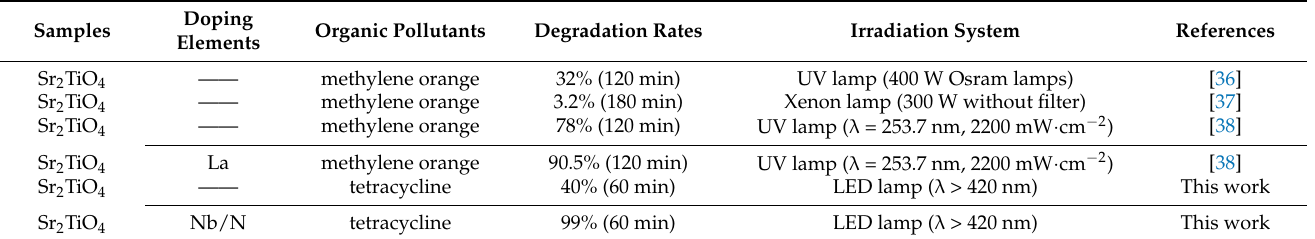
Figure 9. ( a ) Adsorption of different photocatalysts towards TC; ( b ) Self-degradation rate and degradation rate with different photocatalysts of tetracycline under visible light; ( c ) pseudo-first order kinetics curves of the photocatalytic degradation of TC; ( d ) degradation rate of TC after repeated cycles by Sr 2 TiO 4 :N,Nb(2%). Table 3. Photocatalytic properties of Sr 2 TiO 4